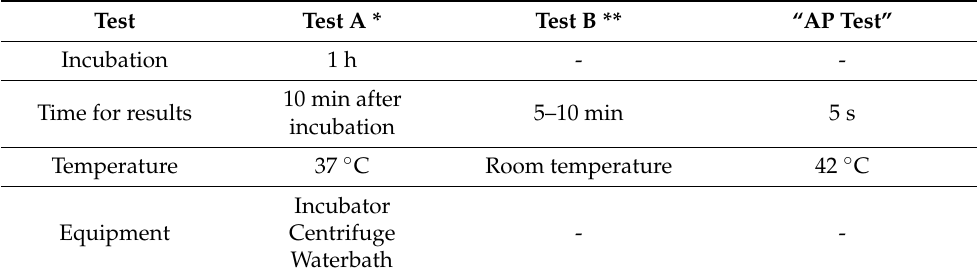
Table 4. Comparison of the methods used to detect